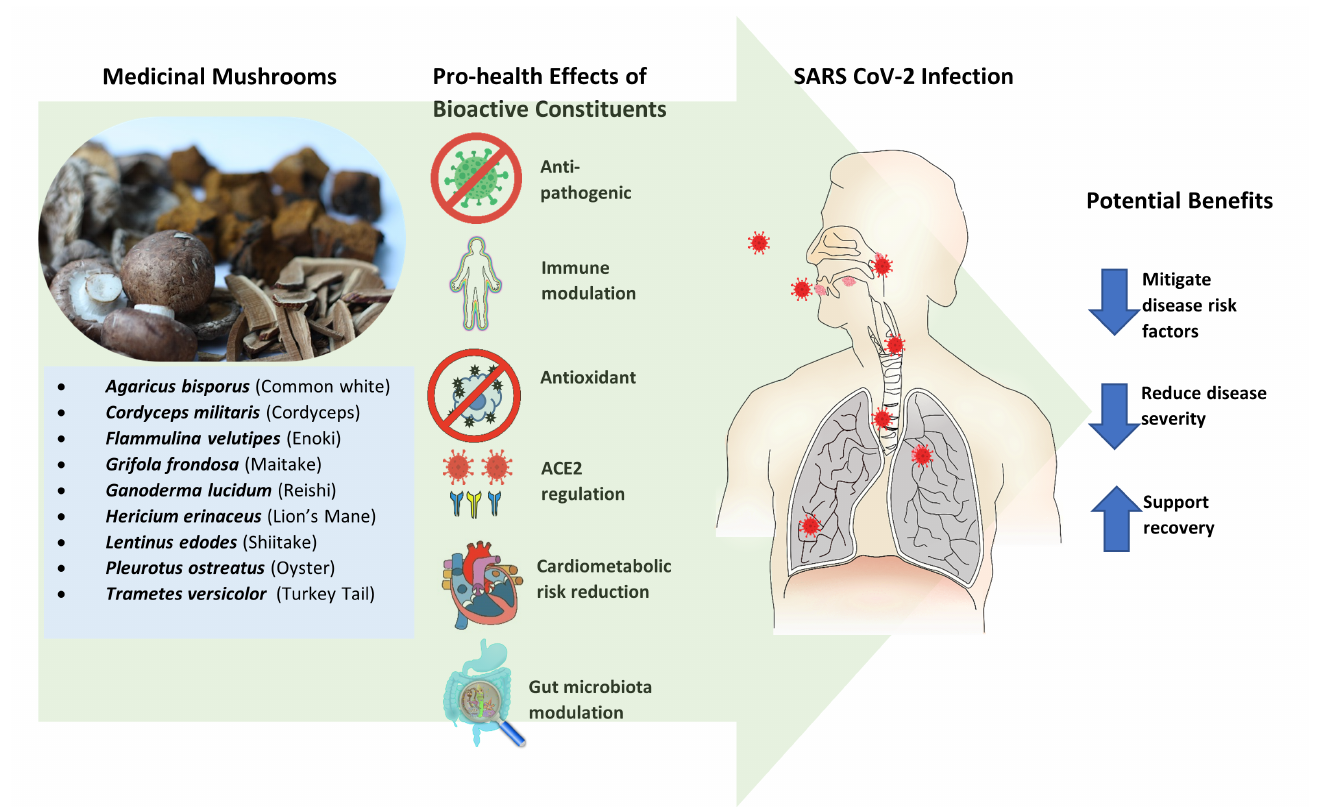
Figure 1. Medicinal mushrooms demonstrated modulatory and regulatory effects via the actions of bioactive compounds. These effects may apply in the pathophysiology and sequelae of SARS